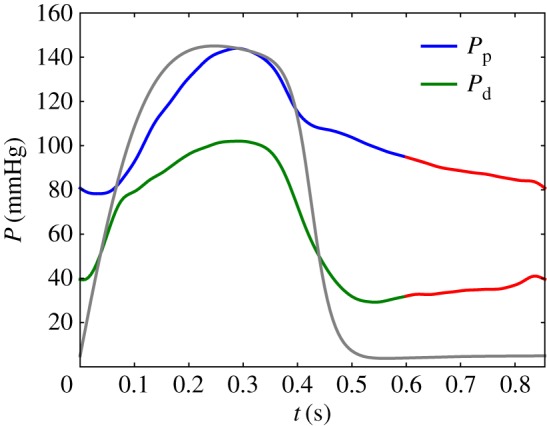
Proximal Pp and distal Pd pressure waveforms obtained during invasive angiography, together with a computed left ventricle pressure waveform in grey. The last 30% of the cardiac cycle is highlighted in red and was used to compute the instantaneous wave-free ratio, iFR, a drug-free index of the significance of the stenosis.